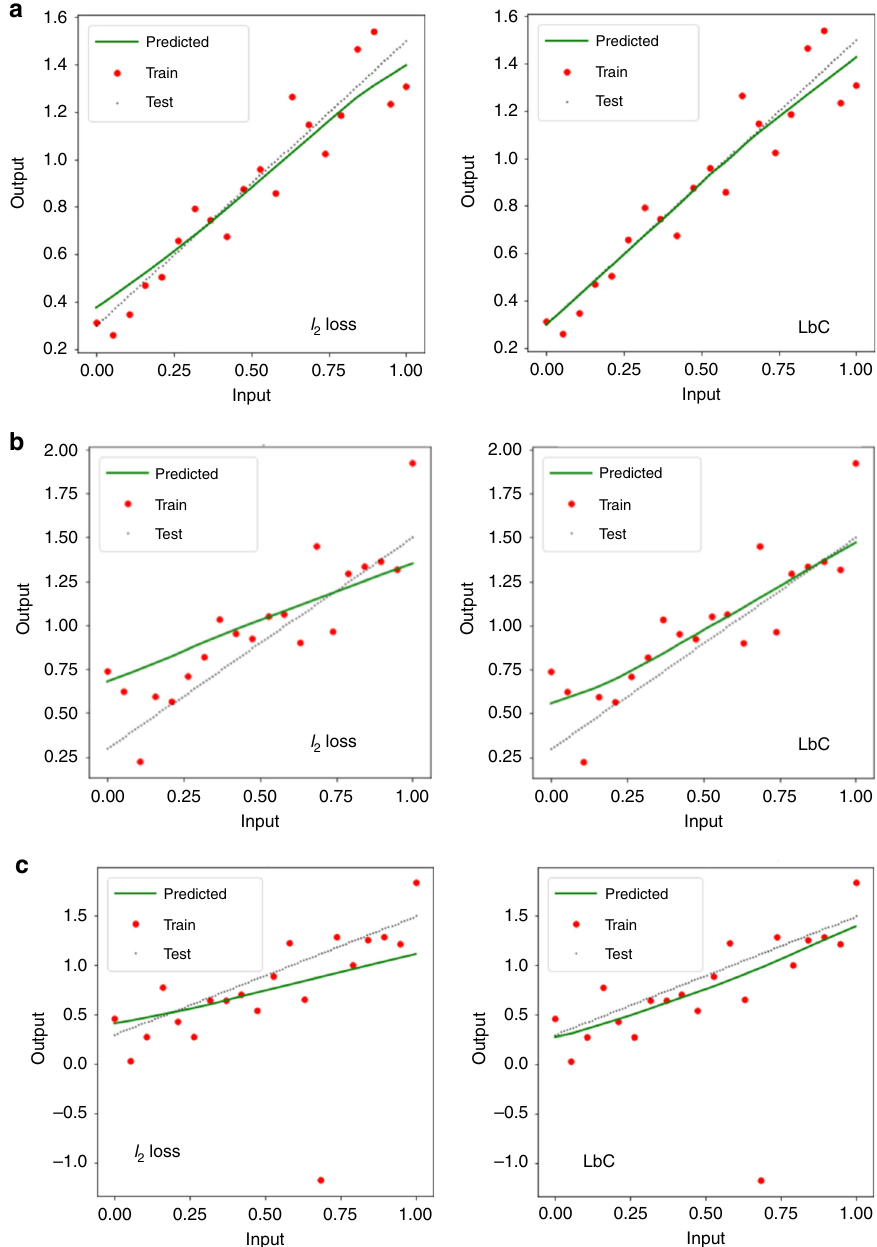
Fig. 1 Illustration with a 1D regression example. Comparing models trained using the symmetric ℓ 2 loss and Learn-by-Calibrating (LbC). a When the noise model for the observed data is symmetric (Gaussian in this case), even the standard MSE loss can recover the true function. b When the noise model is asymmetric (positive skew), symmetric losses lead to poor approximations. In contrast, LbC can produce higher- fi delity predictions by not enforcing a symmetric residual structure. c When there are outliers in addition to an asymmetric (negative skew) noise model, the nonrobustness of the squared error metric becomes clearly evident, while LbC is found to be